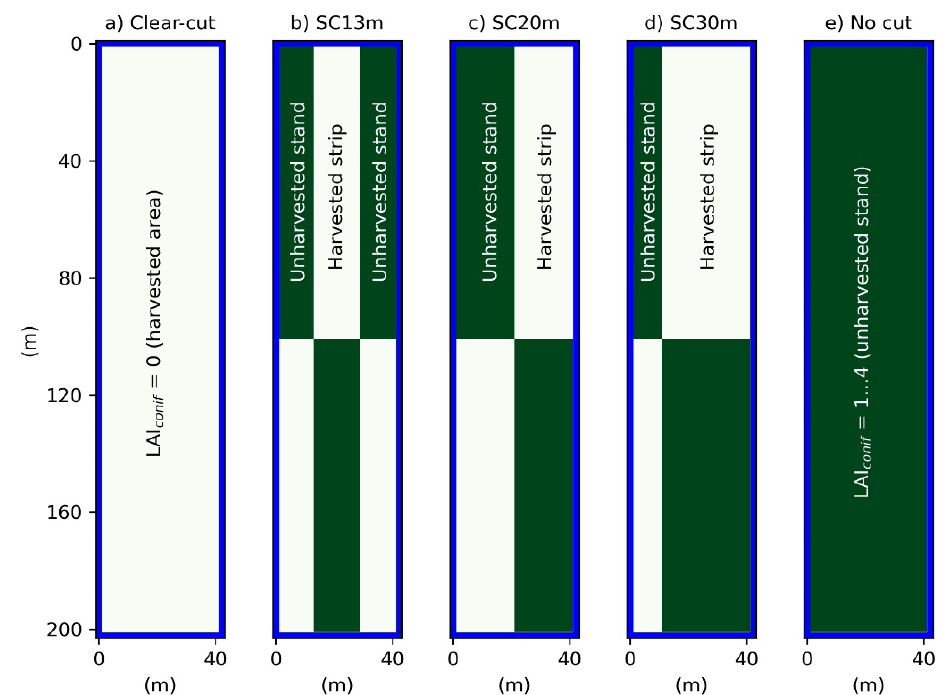
Figure 2. Tree stand layouts ( a – e ) tested in the study. The leaf area index (LAI conif , one sided) in the area of the standing trees varied between 1 and 4. There were no trees in the harvested strips. The strip cut (SC) layouts ( b – d ) are named according to strip width (i.e., 13, 20, and 30 m). The blue lines indicate ditches surrounding the areas.